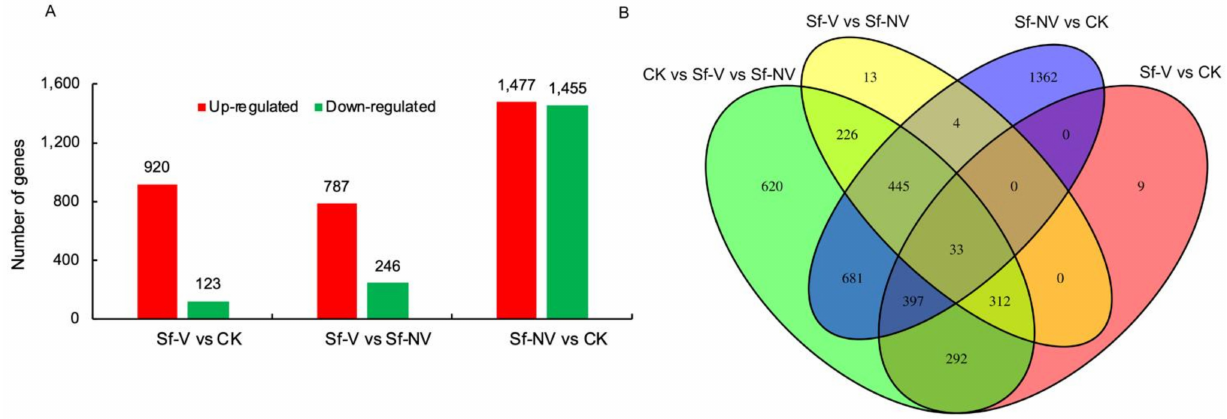
Figure 2. Differentially expressed genes (DEGs) between S. furcifera treatments: Sf–V, S. furcifera females acquired SRBSDV; Sf–NV, S. furcifera females failed to acquire SRBSDV; CK, S. furcifera females exposed to healthy rice plants: ( A ) up- and downregulated DEGs between treatments; ( B ) Venn diagram of shared DEGs between treatments. Table 4. Identification of DEGs associated with apoptosis in S. furcifera females. Gene